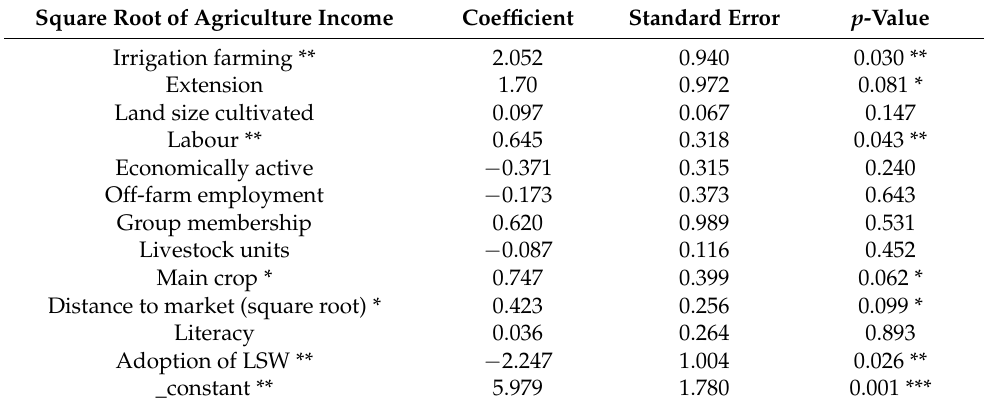
Table 6. Impact of the adoption of irrigation farming on agricultural income: OLS results. Square Root of Agriculture Income Coefficient Standard Error p -Value Irrigation farming